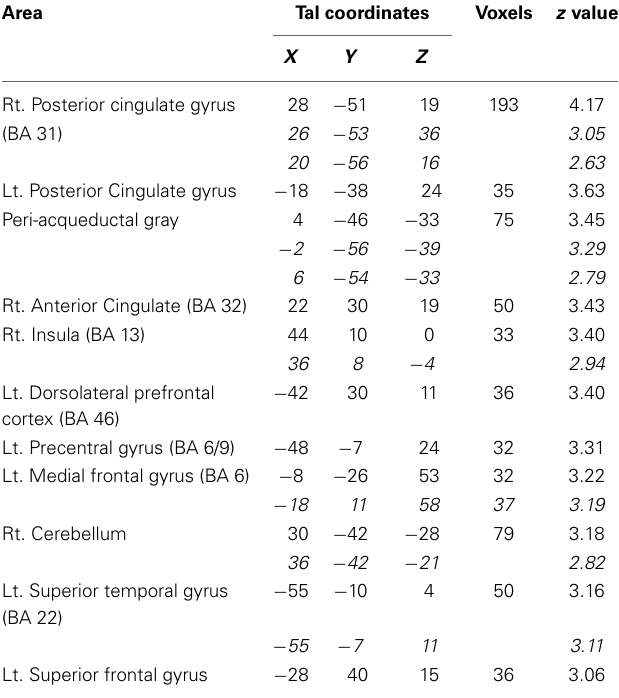
Table 4 | Areas activated by the main effect of intrapersonal emotion regulation (intrapersonal emotion regulation - watch > interpersonal emotion regulation > watch).